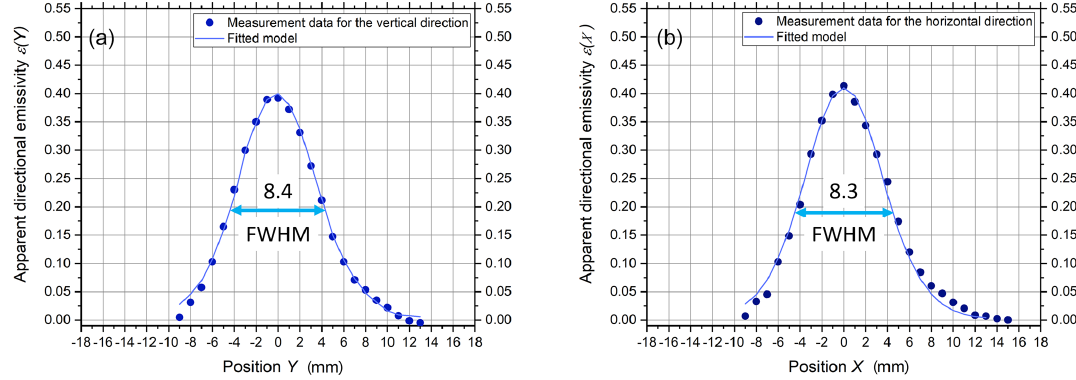
Figure 7. (a, b) Measured apparent directional emissivity ε ( Y ) and ε ( X ) when scanning a round aperture with a radius R ( R = 3mm) over the measurement spot of the TIR 100-2 in the vertical (a) and horizontal (b) directions. The results are compared with a model function integrated over the corresponding area at the respective position Y or X according to Eq. (3). (FWHM refers to the full-width at half-maximum.) Table 2. Measurement field of the TIR 100-2 determined with the two different methods. Definition of the Varied aperture Scanned aperture Scanned aperture measurement field vertical horizontal